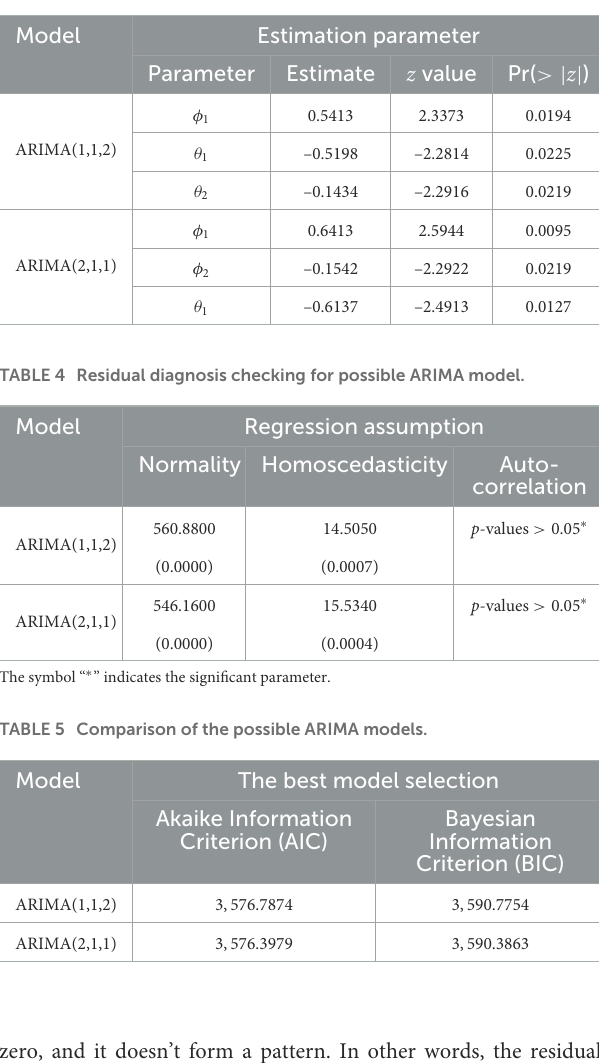
TABLE 3 Estimation significant parameters of ARIMA model.